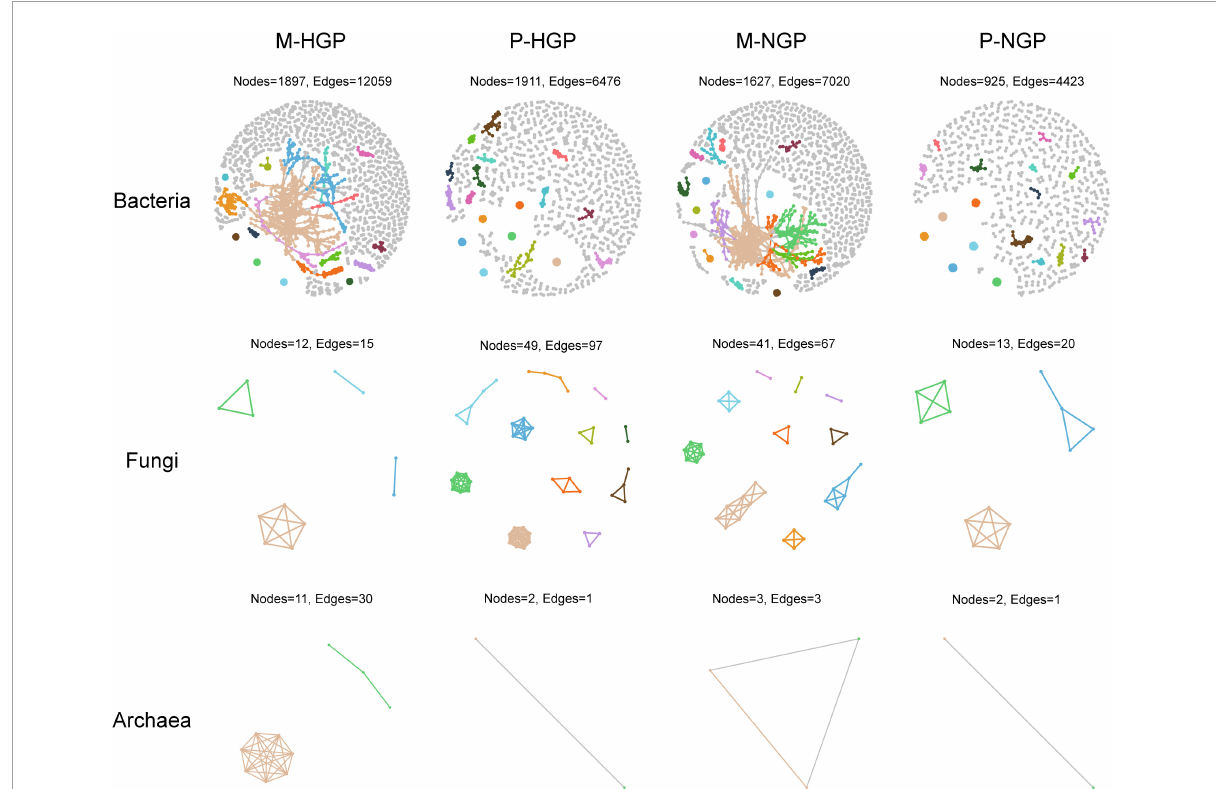
FIGURE4 Co-occurrence networks of soil microbial taxa. Visualization of bacterial, fungal, and archaeal connectivity. The top 18 clusters are distinguished by different colors, with other species represented in gray. Nodes indicate individual microbial species and edges represent significant positive Spearman correlations ( ρ > 0.9; p <